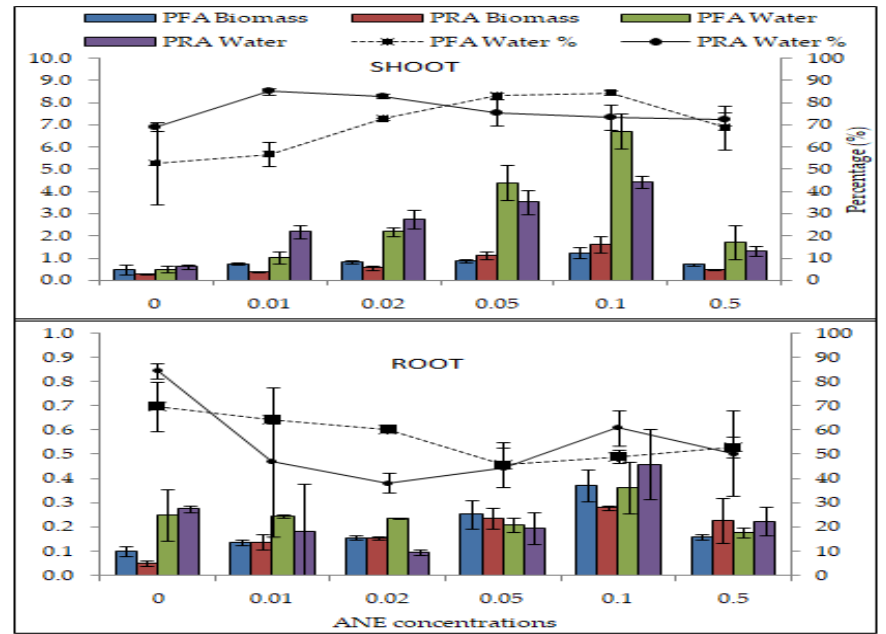
Figure 5. Efficacy of ANE on biomass accumulation in shoots and roots of V. aconitifolia in pot foliar (PFA) and pot root application (PRA). Bar indicates mean ± SD (n = 3).